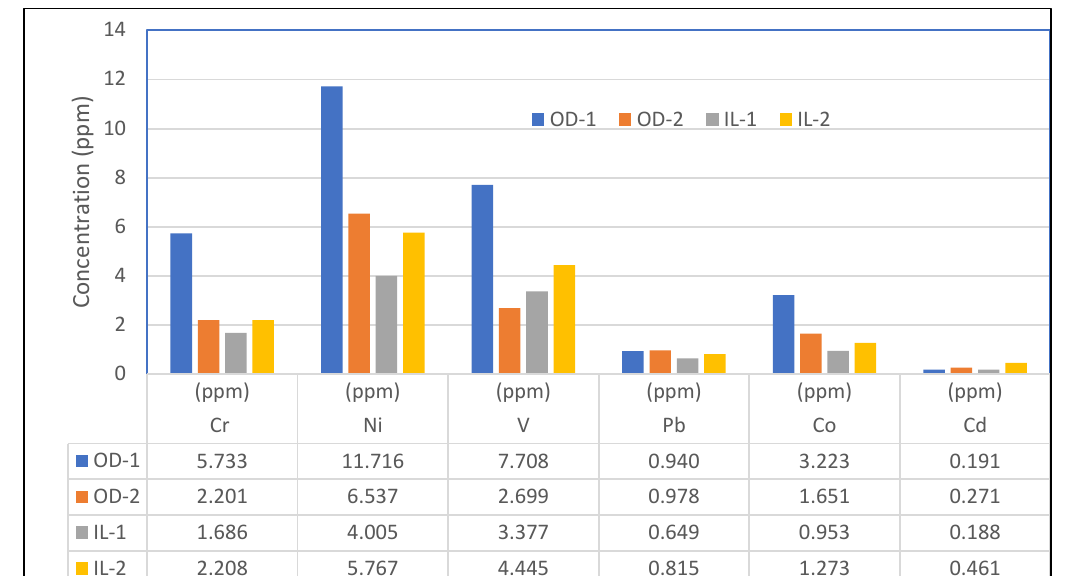
Figure 7. The concentration of Cr, Ni, V, Pb, Co, and Cd in oil sands. The concentrations of Cr, Ni, V, Pb, Co, and Cd in the Citrus were 7.475, 4.981, 0.551, 0.001, 0.806, and 0.177 ppm, respectively. Theobroma Cacao showed Cr, Ni, V, Pb, Co, and Cd concentrations of 7.095, 16.697, 2.151, 0.023, 3.942, and 0.254 ppm, respectively.